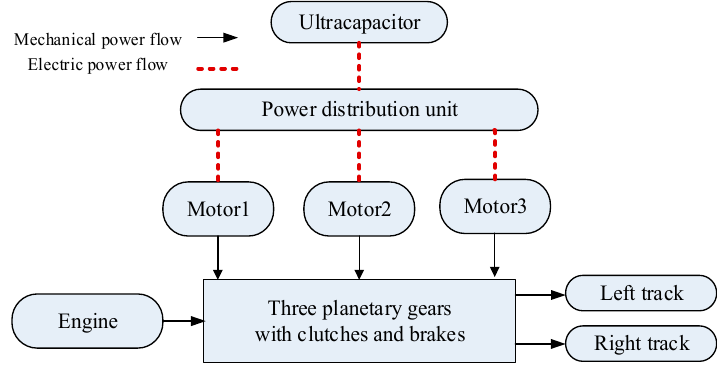
Figure 1. Schematic diagram of the proposed powertrain.